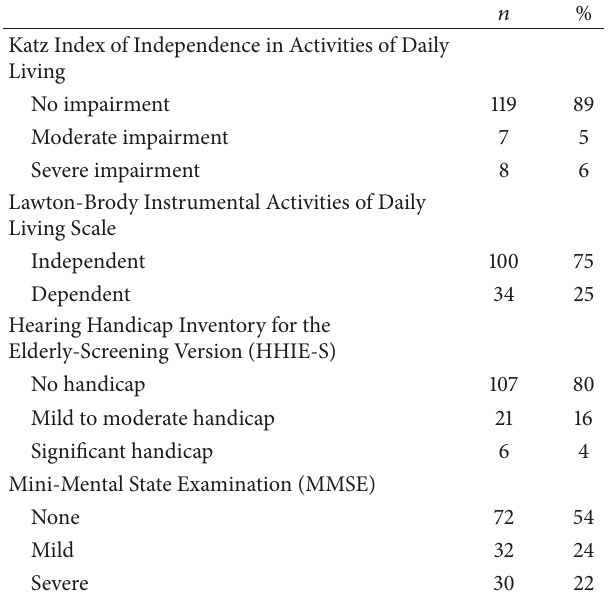
Table 2: Functional status among the study participants.